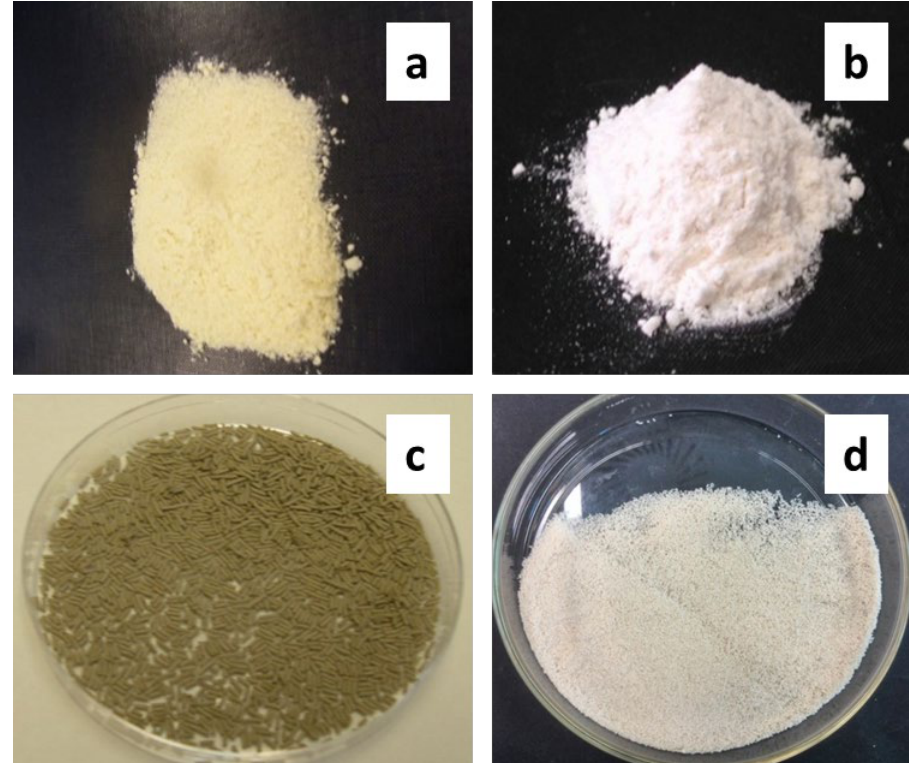
Figure 6. Examples of physical aspect from different solid formulates: ( a ) freeze-drying WP, ( b ) spray-drying SP, ( c ) fluidized bed drying WG and ( d ) fluidized bed spray-drying WG.